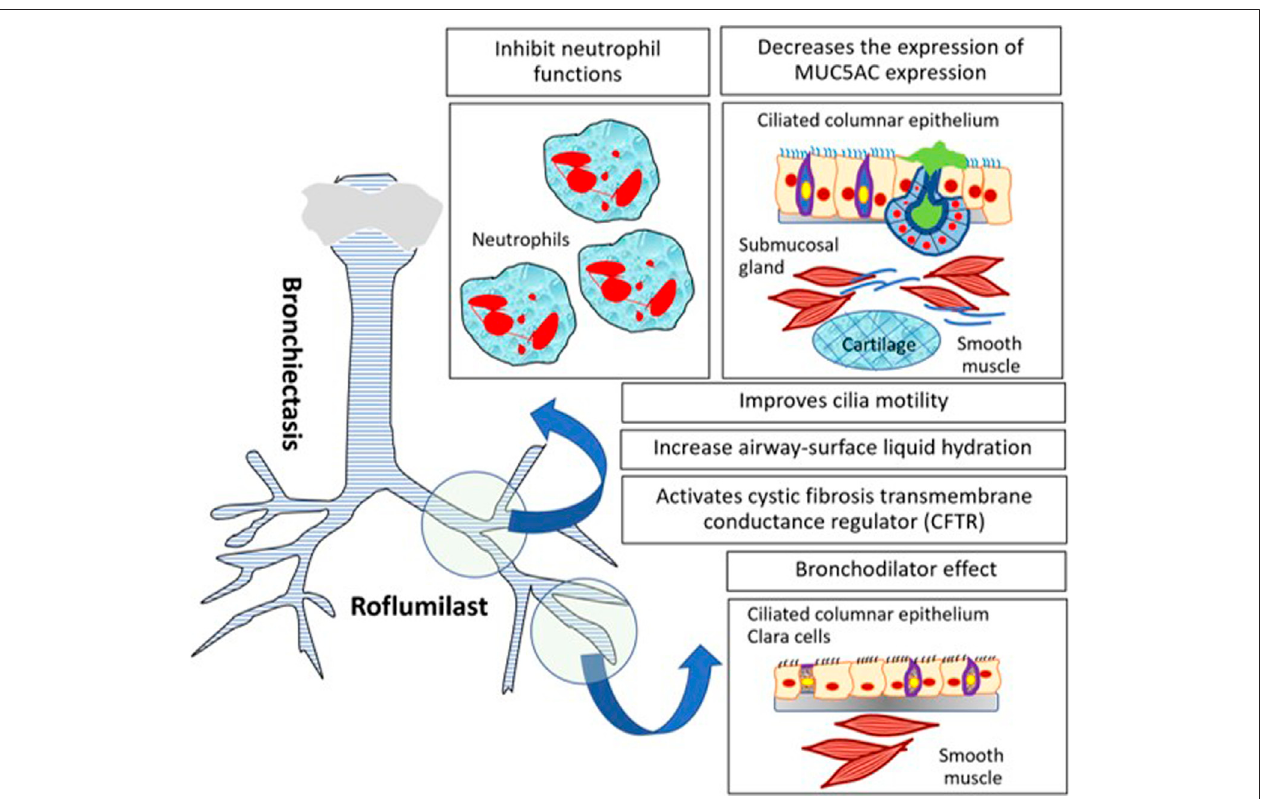
FIGURE 1 | The potential role of ro fl umilast and PDE4 inhibitors in COPD with speci fi c phenotypes or COPD with comorbidities.